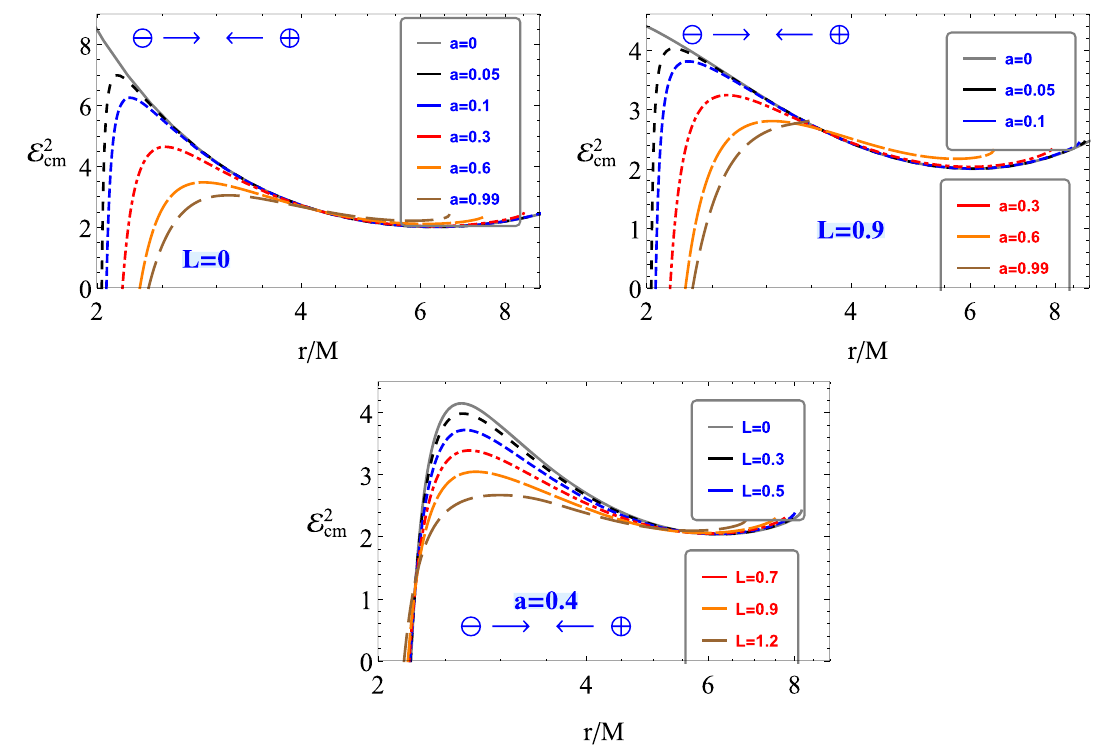
Fig. 18 As in Fig.17, but for positive and negative charged particle collisions. Units in which M =